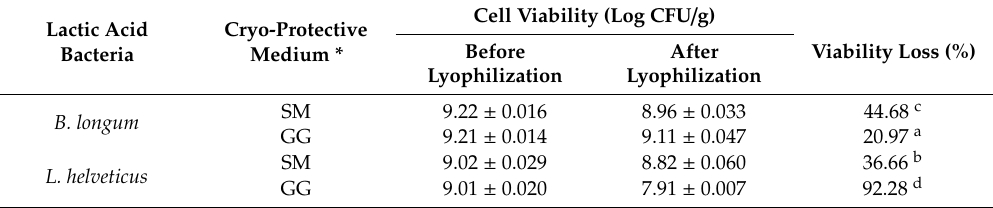
Table 2. Viability of probiotic lactic acid bacteria (LAB) as a ff ected by lyophilization (means ± standard deviation